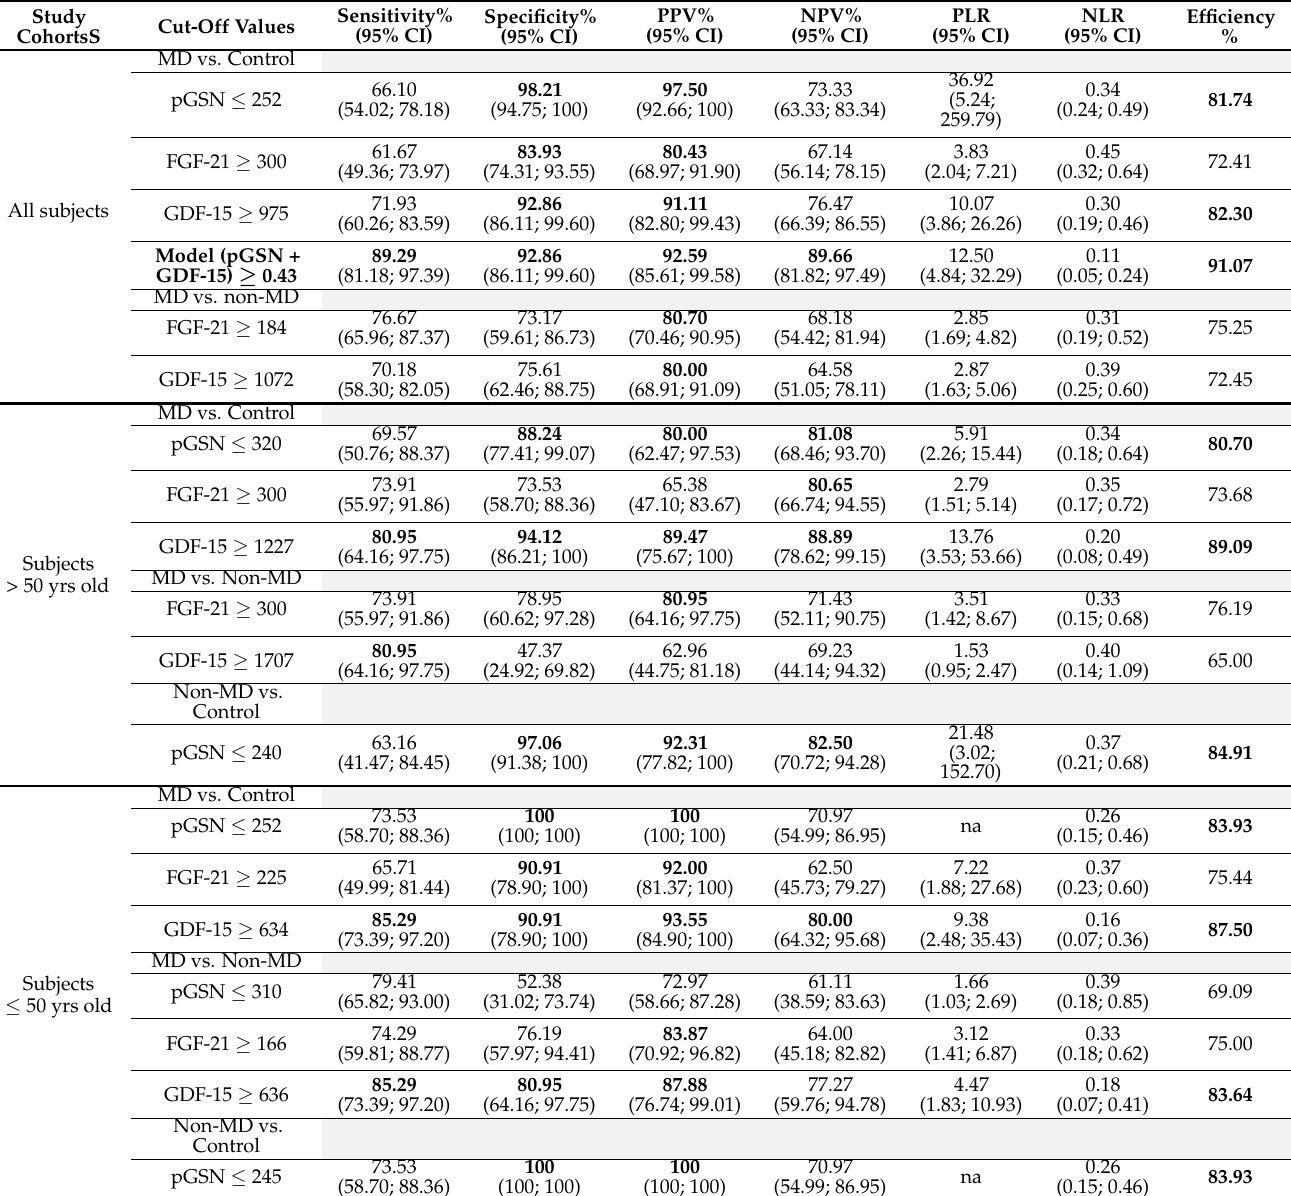
Table 3. General features of the plasma biomarkers pGSN, FGF-21, and GDF-15.